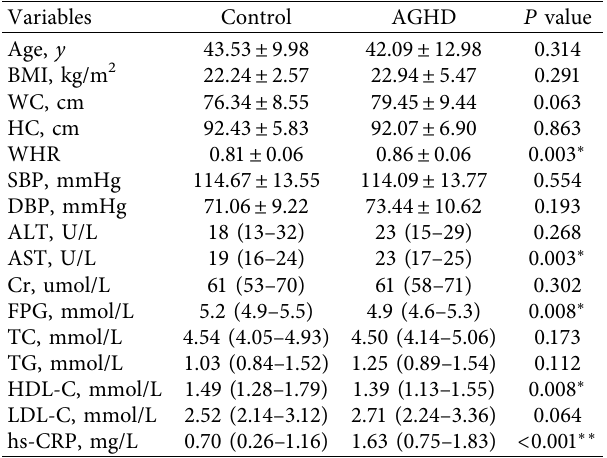
Table 1: Baseline features of the AGHD patients and the healthy control